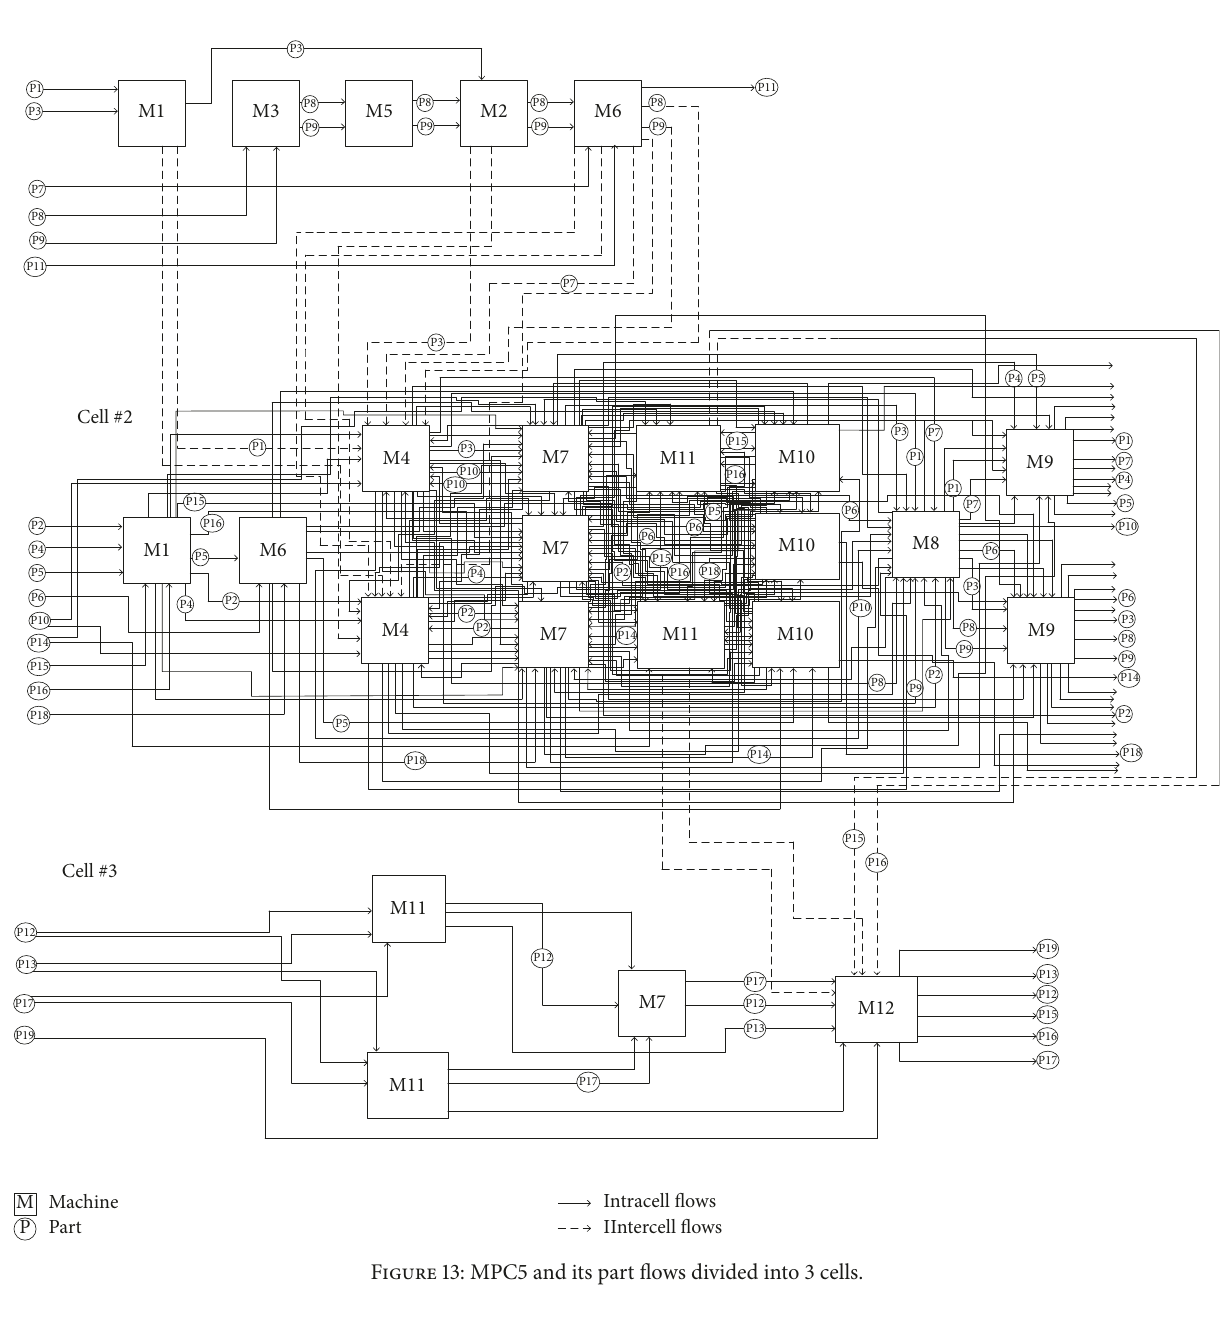
Figure 13: MPC5 and its part flows divided into 3 cells.